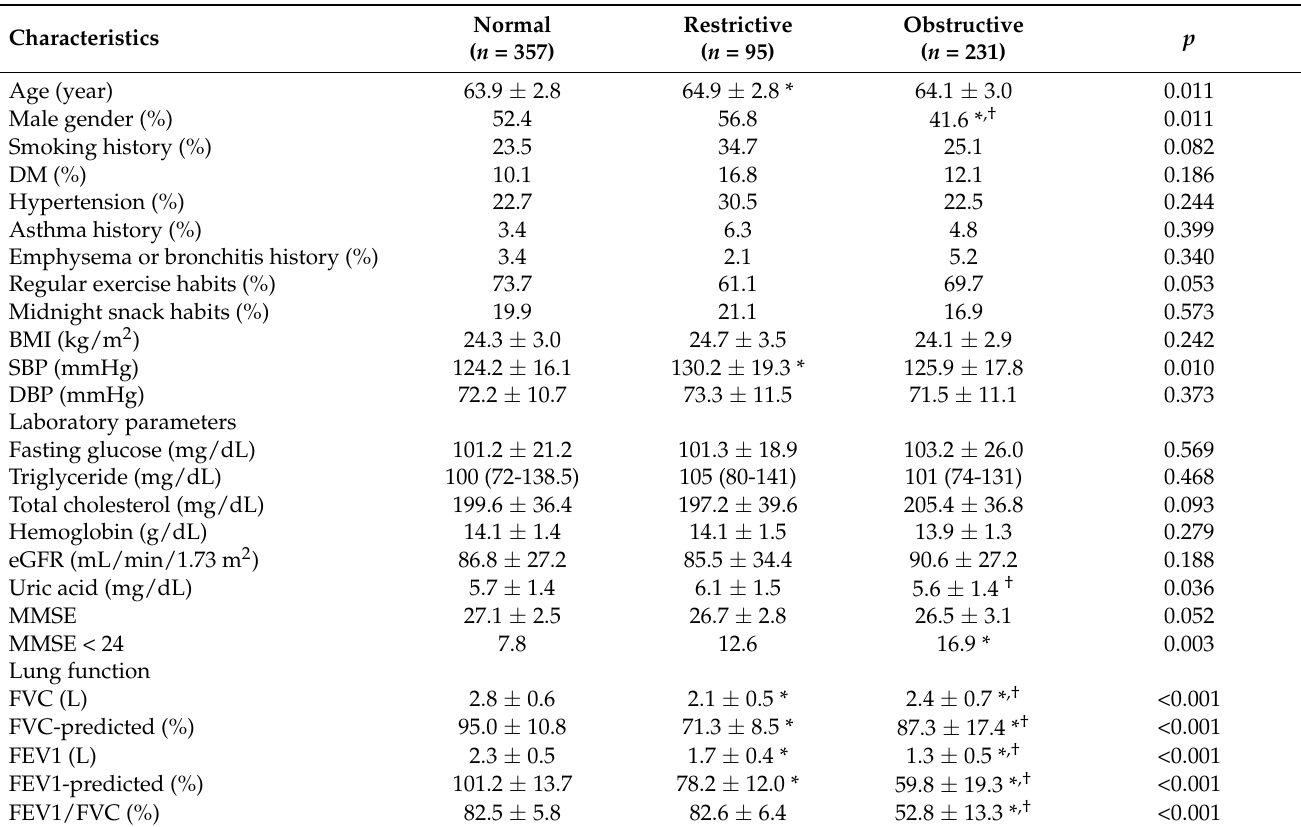
Table 1. Comparison of clinical characteristics among participants according to lung